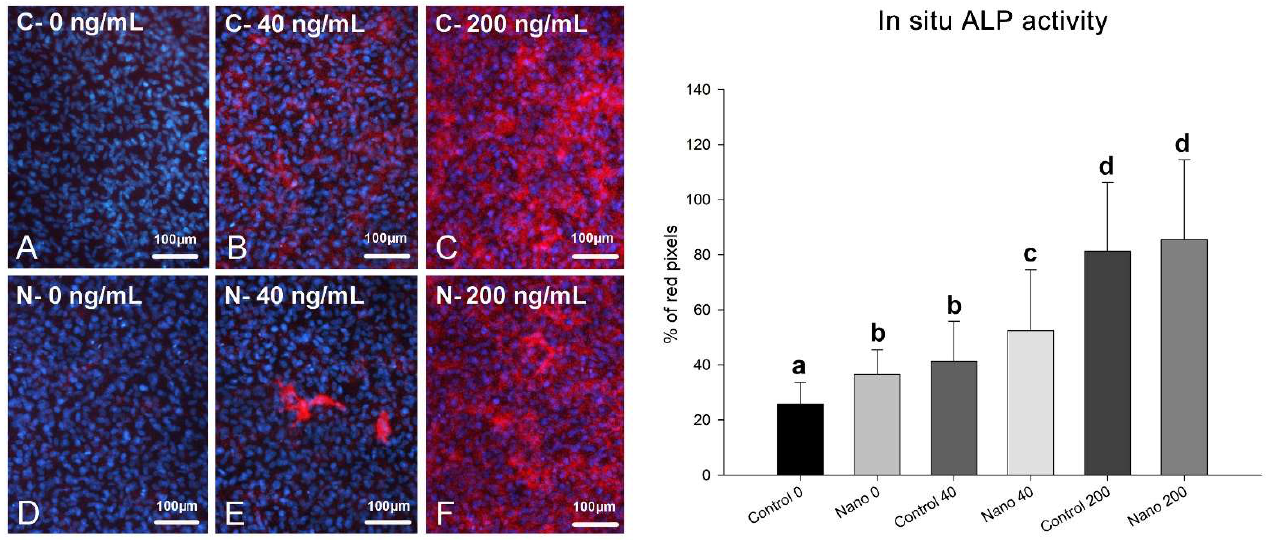
Figure 3. Epifluorescence imaging of Fast Red staining (left panel) and in situ ALP activity (right panel) of MC3T3-E1 cells on day 5 of culture on Control-Ti ( A – C ) and Nano-Ti ( D – F ) exposed or not on days 2 and 4 of culture to 40 and 200 ng/mL BMP-7 in the culture medium. ( B , C , E , F ) Whole-cell red fluorescence (Fast-Red-stained cells) indicates in situ ALP activity, and cell nuclei blue fluorescence indicates DAPI DNA stain. Bars with different letters are significantly different from each other ( p < 0.05).